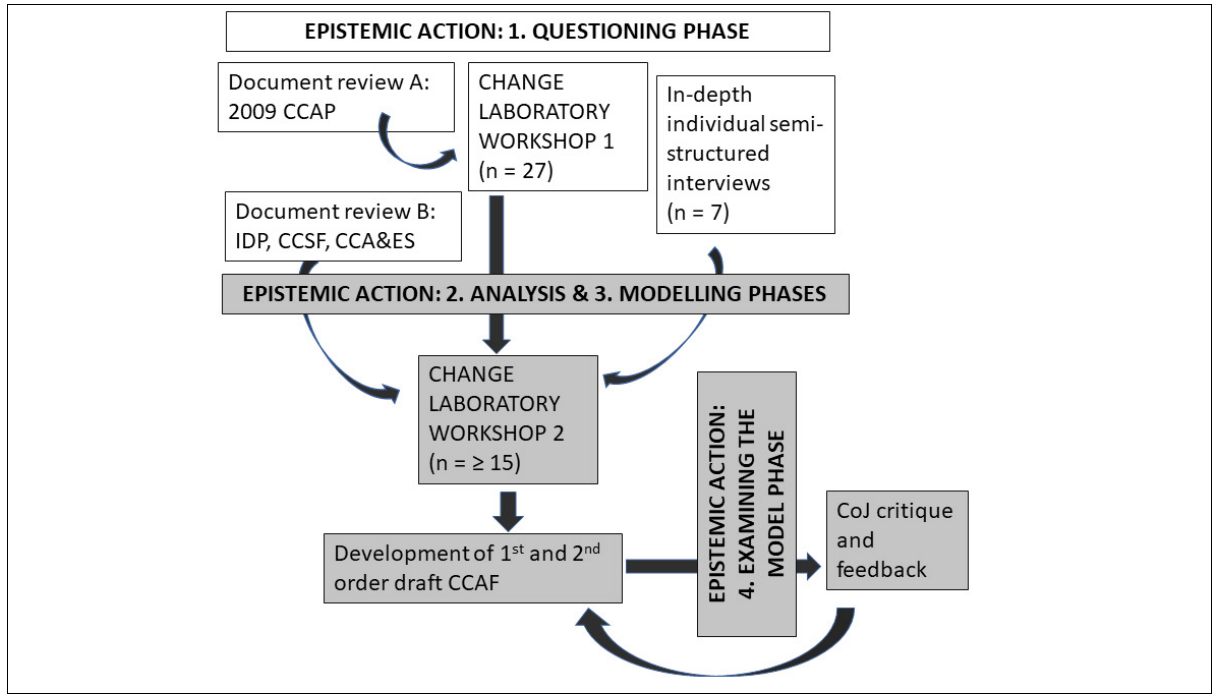
Figure 4: Research sequence of epistemic actions in the development of the City of Johannesburg’s (CoJ) Climate Adaptation Framework (CCAF) including the action steps and methods used. The second Change Laboratory had more than 15 participants present ( n =15–20), but participants arrived/ left periodically due to other work-related obligations, with n =15 present for the full duration. CCAP = Climate Change Adaptation Plan; IDP = Integrated Development Plans; CCSF = Climate Change Strategic Framework; CCA&ES = EISD’s Climate Change Activation and Engagement Research Article 5 Volume 117| Number 9/10 https://doi.org/10.17159/sajs.2021/7929 September/October 2021